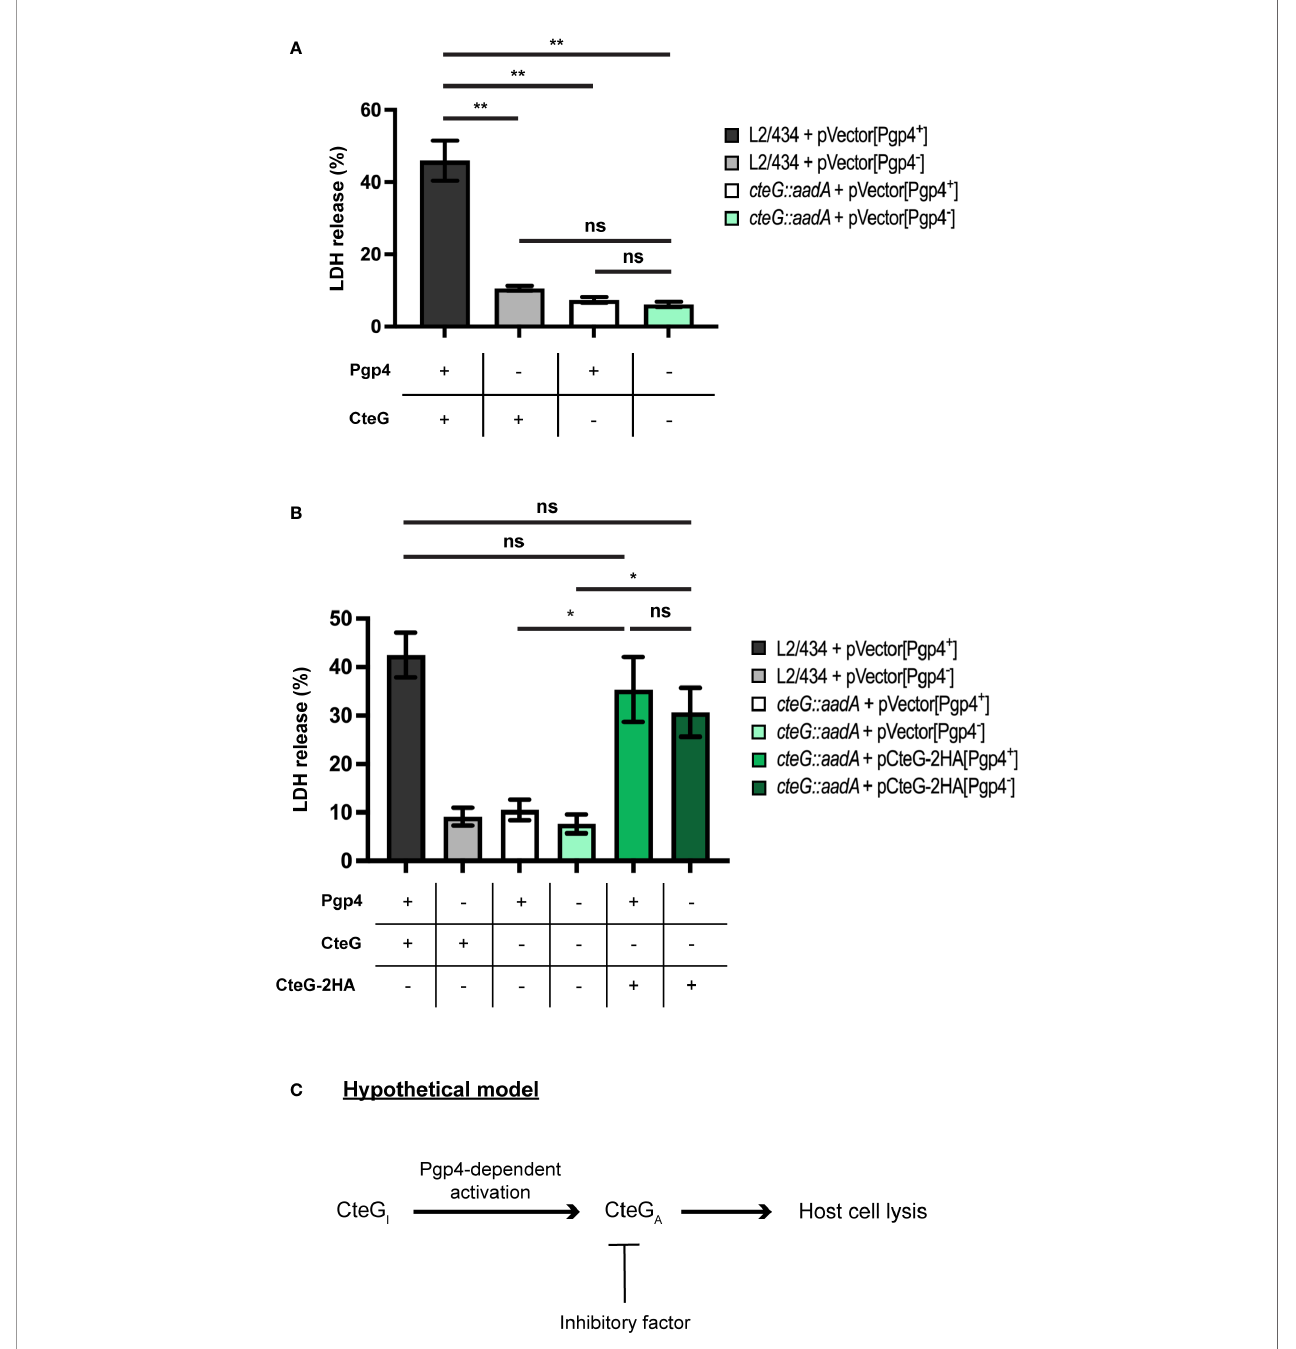
FIGURE 5 | C. trachomatis mediates host cell lysis via a common pathway involving both CteG and Pgp4. (A) HeLa cells were infected with C. trachomatis L2/434 carrying pVector[Pgp4 + ] (CteG + /Pgp4 + ), L2/434 carrying pVector[Pgp4 - ] (CteG + /Pgp4 - ), cteG::aadA carrying pVector[Pgp4 + ] (CteG - /Pgp4 + ), or cteG::aadA carrying pVector[Pgp4 - ] (CteG - /Pgp4 - ) for 72 h at an MOI of 0.3, and the LDH released by lysed host cells was measured using a CytoScan ™ LDH Cytotoxicity Assay kit (G- Biosciences). (B) As in panel A, but HeLa 229 cells were also infected with cteG::aadA carrying pCteG-2HA[Pgp4 + ] (also named pCteG-2HA in Table 1 and in Figures 1 – 3 ; CteG-2HA + /Pgp4 + ), or cteG::aadA carrying pCteG-2HA[Pgp4 - ] (CteG-2HA + /Pgp4 - ). Statistical signi fi cance was assessed by using ordinary one-way ANOVA and Tukey post-test analysis. In (A, B) , data correspond to mean ± standard error of the mean (n = 4 in panel A and n = 7 in panel B; ns, non-signi fi cant; *p<0.01; **p<0.0001). (C) Hypothetical model for the mode of action of CteG and Pgp4 in promoting host cell lysis. After CteG is produced by chamydiae in an inactive form (CteG I ), CteG is activated (CteG A ) in a Pgp4-dependent manner, which could occur within chlamydiae or after delivery of CteG into the host cell cytoplasm. Premature